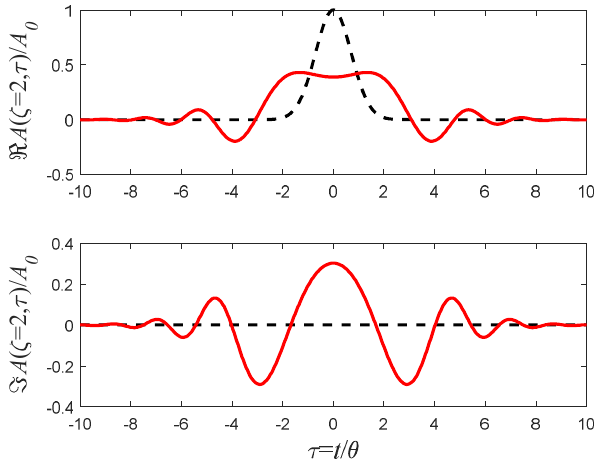
Figure 1. The real (upper panel) and imaginary (lower panel) components of the pulse (Equation (14)). The dashed curve represents the initial profile (for ζ = β 2 z / θ 2 = 0), while the solid curve represents the signal after a distance, which corresponds to ζ = β 2 z / θ 2 = 2. Time is measured in units of θ , which corresponds to the pulse’s temporal width.